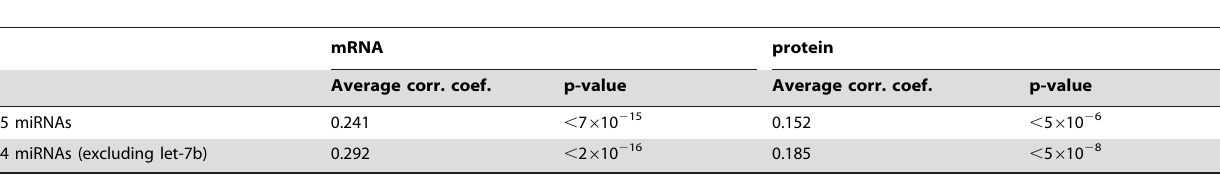
mRNA protein Average corr. coef. p-value Average corr. coef.